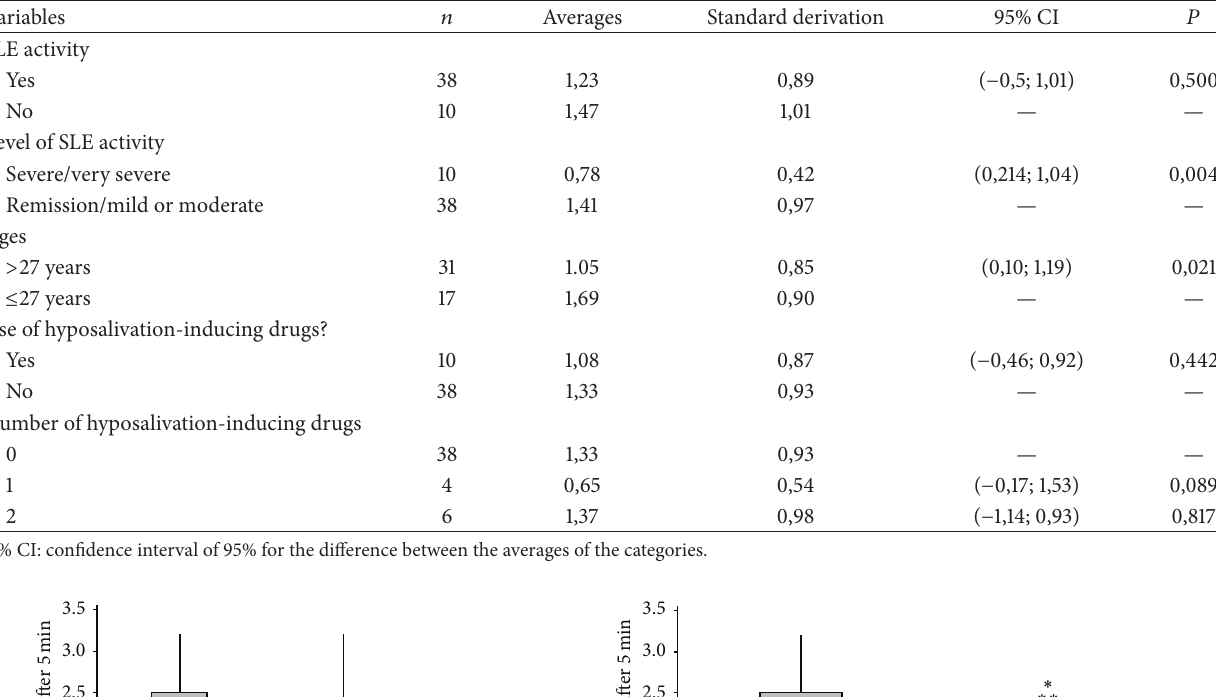
Table 1: Average of saliva collected per variables considered from 48 patients at the HGU-UNIC, Cuiaba, MT, 2014.